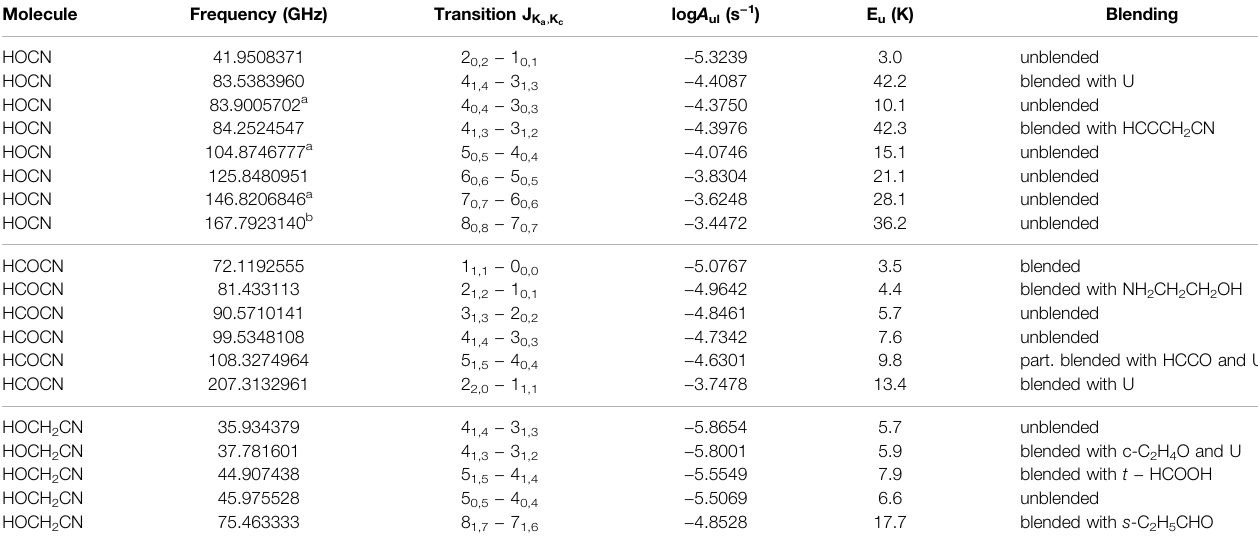
TABLE 2| Listofdetectedtransitions ofthe oxygen-bearingnitriles analysed in this work. Weindicate the frequency, quantum numbers, logarithmof theEinsteincoef fi cient ( A ul ), energy of the upper levels of each transition (E u ), and information about the possible blending by other identi fi ed or unidenti fi ed (U) species towards G +0.693. Molecule Frequency (GHz) HOCN